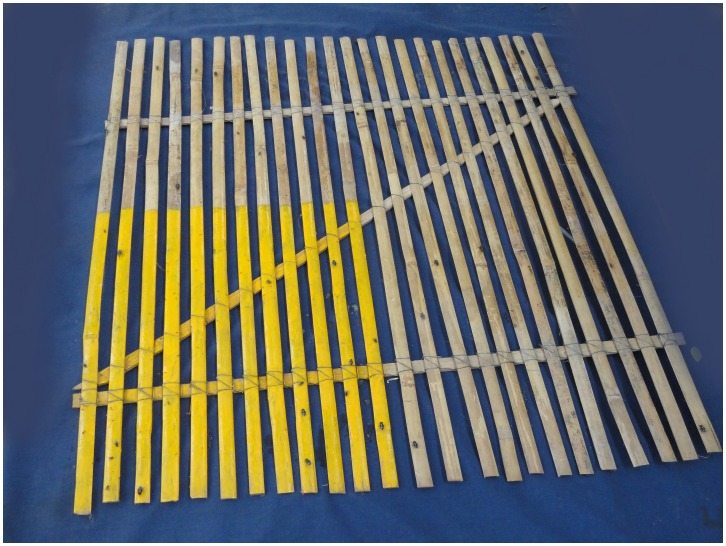
Scudder grill housefly enumeration device in use in Mirzapur.